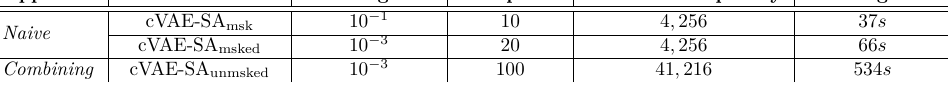
Table 5: Information on the cVAE-SA model considered in this setting ( batch size =